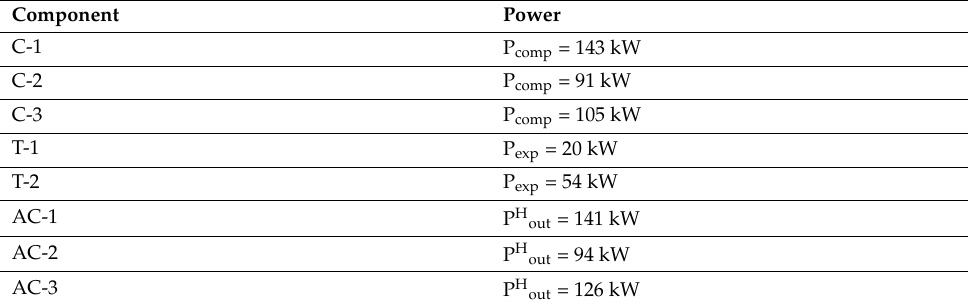
Table A4. This power data refer to operating unit in DE.